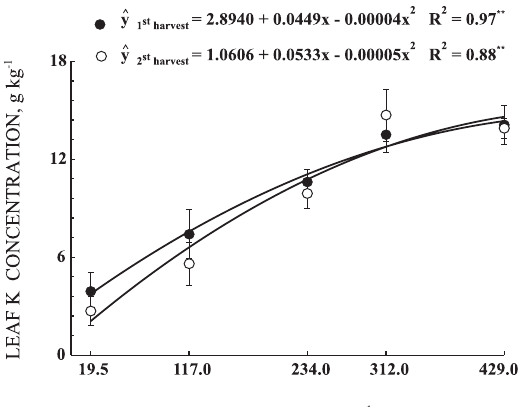
Figure 4. Leaf potassium concentration in the newly expanded leaf lamina (NL) of ‘Mombaça’ grass, in the first ( ) and second ( )growths, related to K